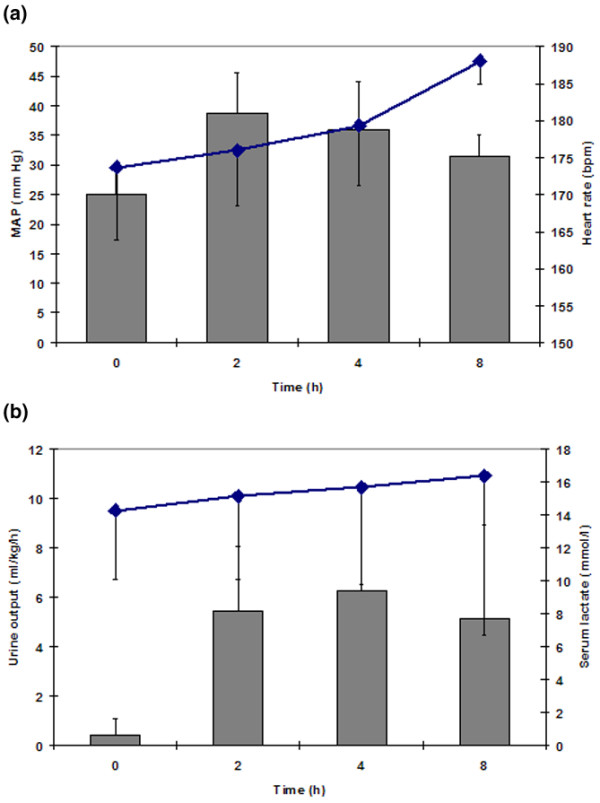
Cardiovascular parameters and urine output and serum lactate in ELBW infants with sepsis before and after initiation of arginine-vasopressin therapy. (a) Cardiovascular parameters: columns show mean arterial blood pressure (MAP; mmHg); lines show heart rate (beats per minute). Values given as mean ± standard deviation. (b) Urine output and serum lactate: columns show urine output (ml/kg body weight/h); lines show serum lactate (mmol/l). Values given as mean ± standard deviation.